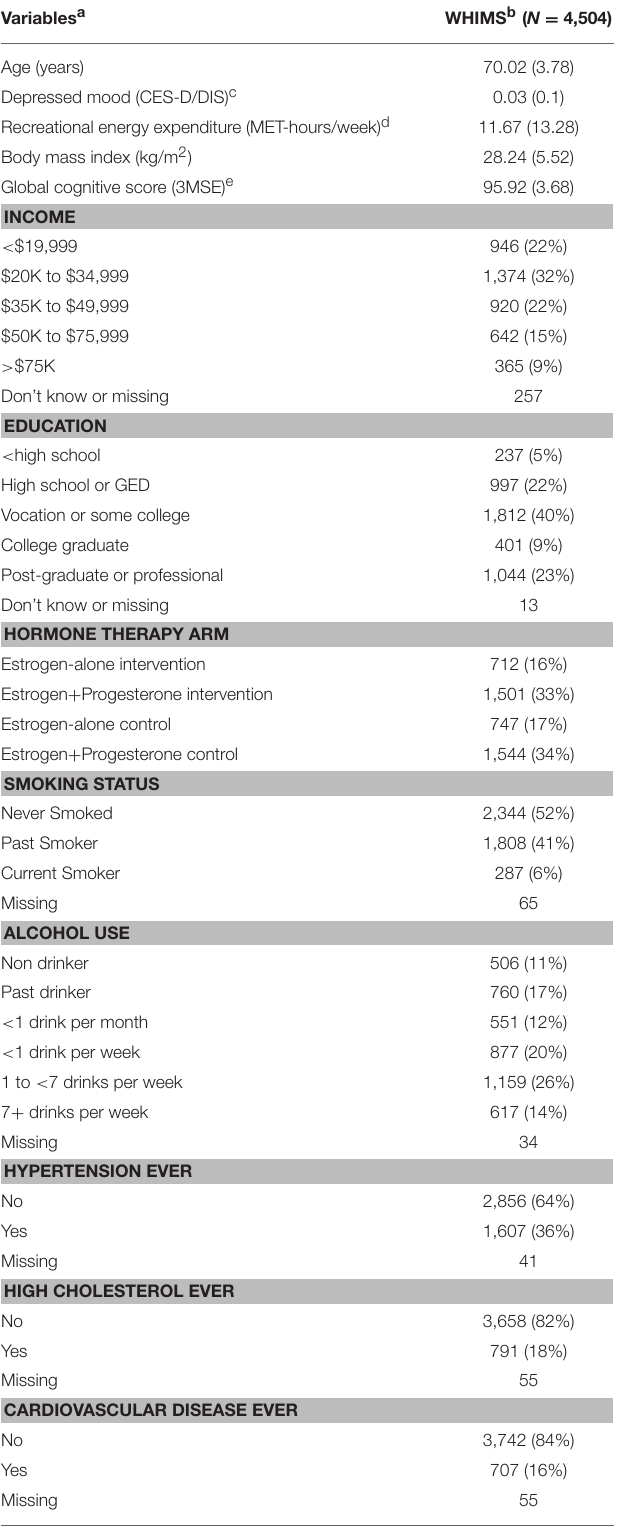
Table S5. 4,284 participants have valid 3MSE scores from